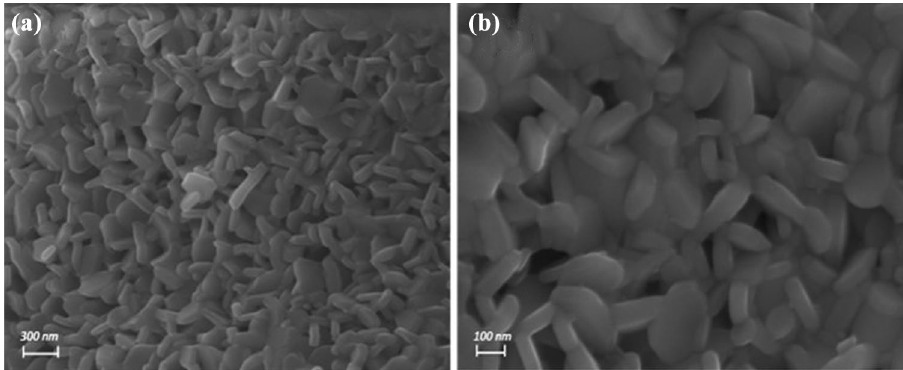
Figure 6. Scanning electron microscopy images of the prepared samples ( a ) BFO and ( b ) BFO/Cefotax.